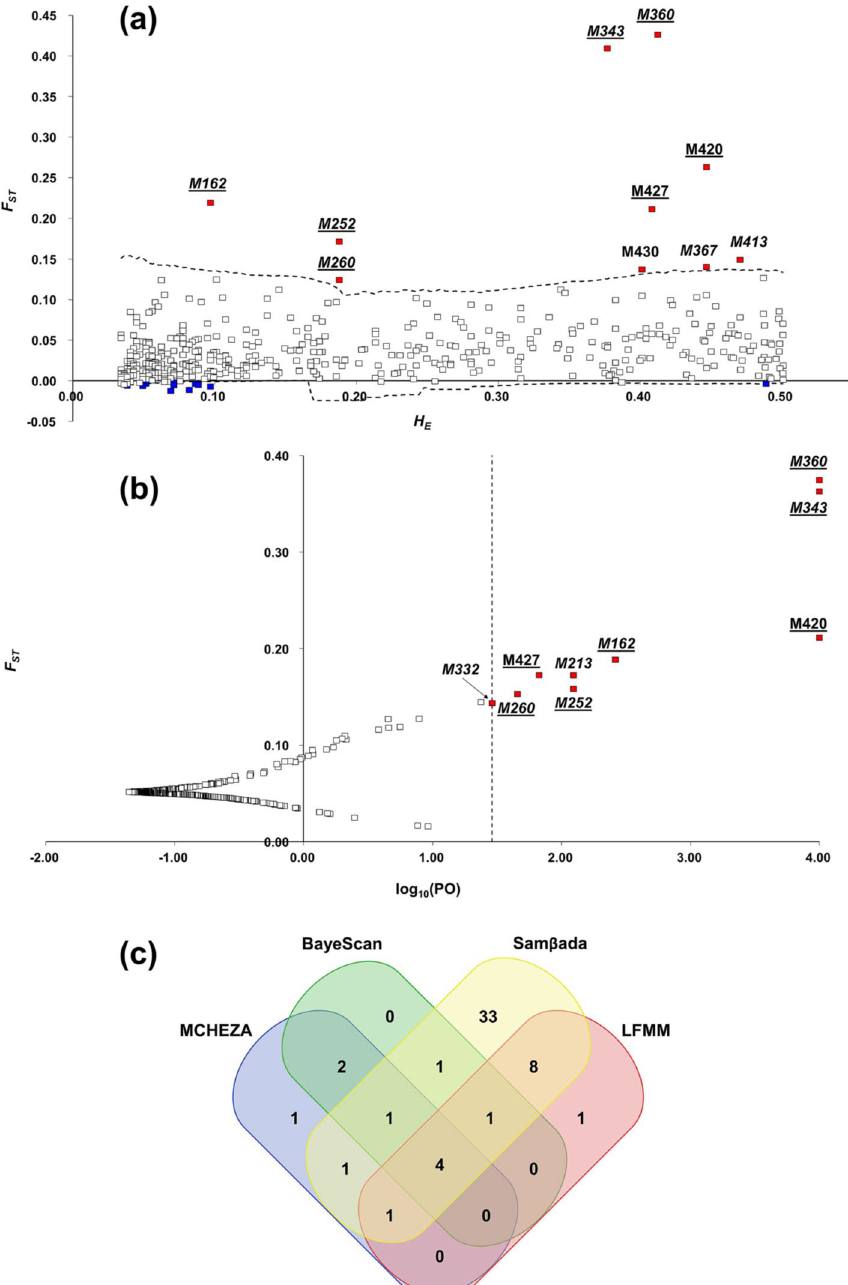
Figure 3. Identification of F ST outlier loci using ( a ) Mcheza and ( b ) BayeScan and ( c ) the Venn diagram summarizing the number of loci identified as F ST outlier loci by Mcheza and BayeScan and significantly associated with environmental variables by Samβada and LFMM. In ( a ) F ST values were plotted against its heterozygosity ( H E ). The dashed lines represent the 99% confidence intervals. Loci under positive selection are indicated as red dots, those under balancing selection as blue dots, and neutral as grey dots. Loci under positive selection detected also by BayeScan are underlined while those identified by Samβada are shown in italics. In ( b ) F ST values were plotted against the log 10 of the posterior odds (PO). The vertical line shows the critical PO used for identifying outlier markers [FDR < 0.01; PO = 29,03; log 10 (PO) = 1463]. Loci under positive selection detected also by Mcheza are underlined while those identified by Samβada are shown in